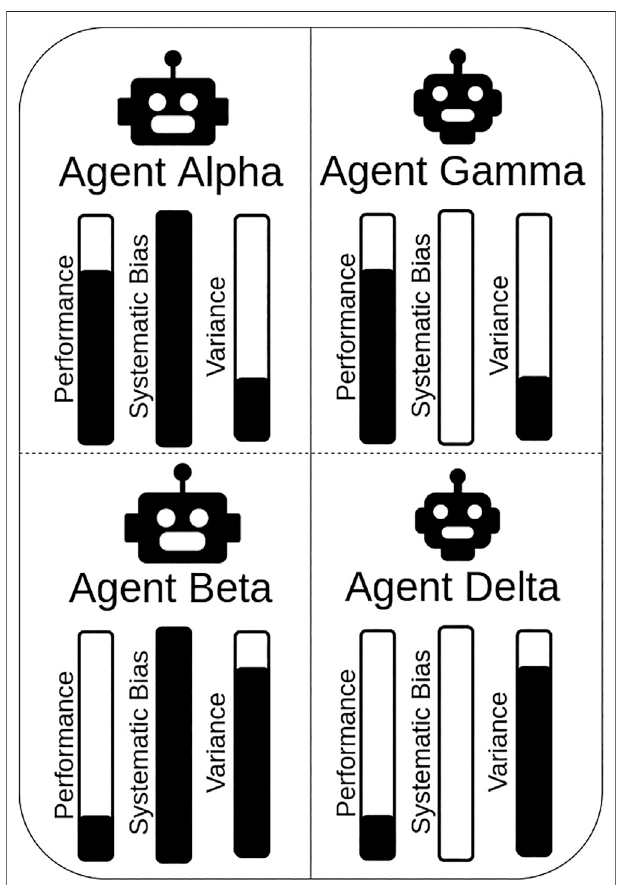
FIGURE 2 | Agents with different degrees of predictability (behaviors) and reliability (performance) were created for this study. Systematic bias and random variance were used to respectively constrain how predictable and accurate the agents ’ accuracy